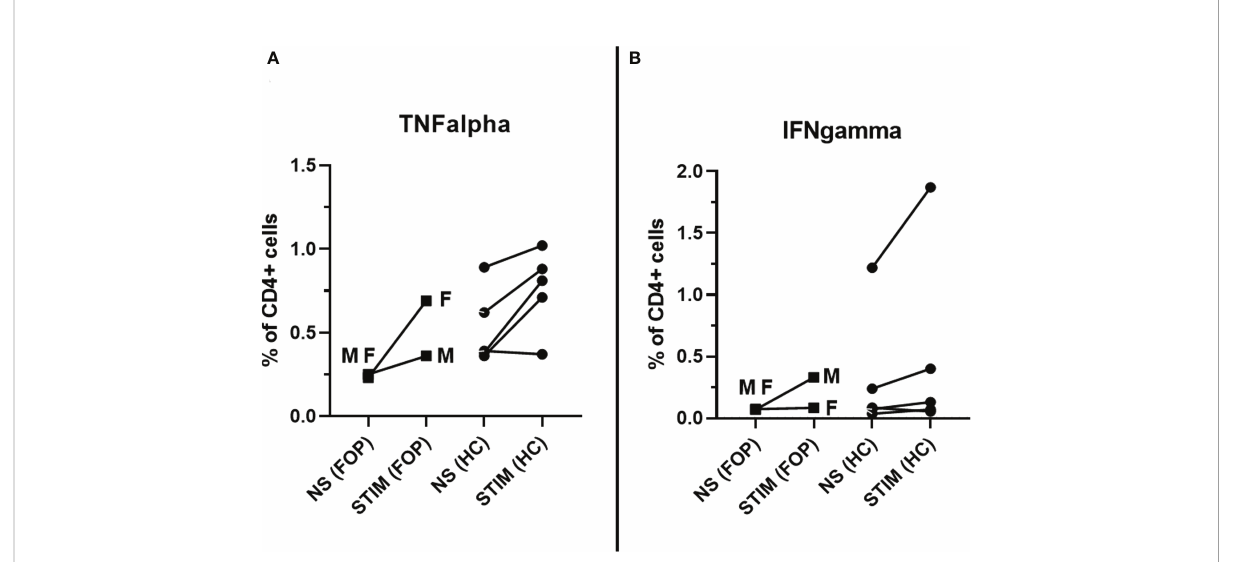
FIGURE 3 Speci fi c post-vaccination cellular response – measured as percentage (%) of CD4+ T cells producing TNF a (A) or IFN- g (B) in unstimulated cells (NS) and after stimulation (STIM) at month 1 in healthy controls (HC) and patients with Fibrodysplasia ossi fi cans (FOP, M- male patient #1, F- female patient